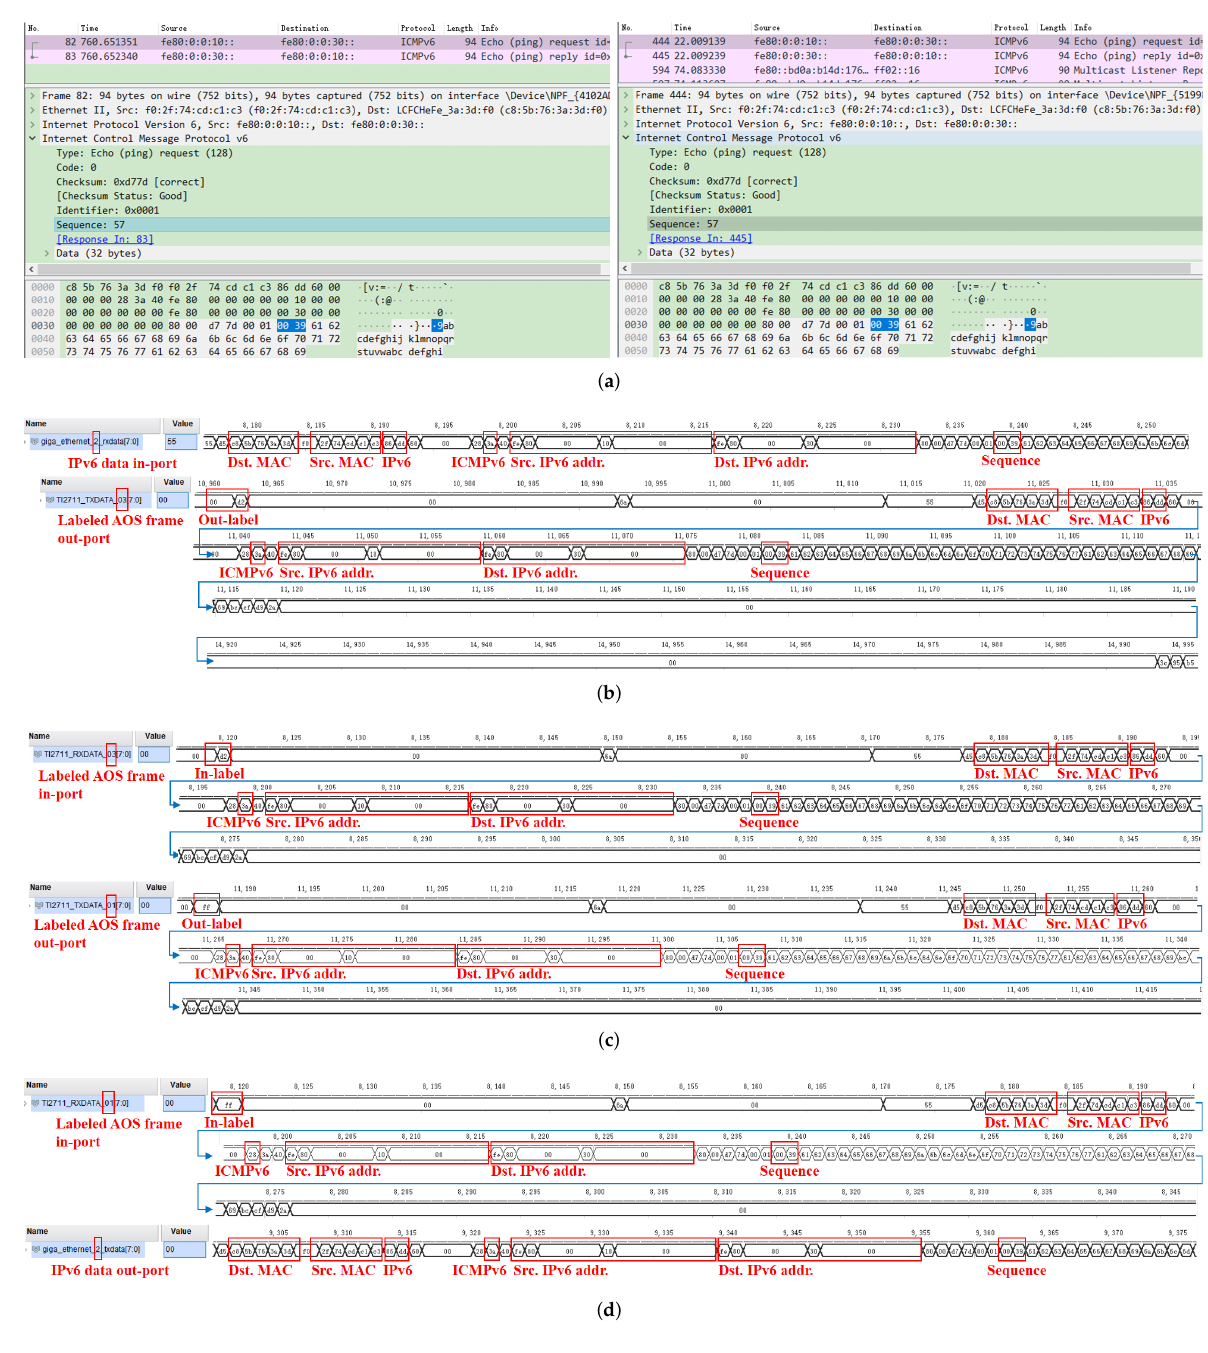
Figure 26. The label-based AOS frame switching in forward label switching path under the cir- cumstances of uni-directional link between node vx_simulator_01 (uni-directional sending) and node vx_simulator_02 (uni-directional receiving) in the semi-physical platform. ( a ) The IPv6 data transmitted from node vx_simulator_01 (ingress LER, SCID 1) to node vx_simulator_03 (egress LER, SCID 3). ( b ) The forward-FIB-based label pushing of AOS frame in node vx_simulator_01 (SCID 1). ( c ) The forward-LFIB-based label swapping of AOS frame in node vx_simulator_02 (SCID 2). ( d ) The forward-FIB-based label popping of AOS frame in node vx_simulator_03 (SCID